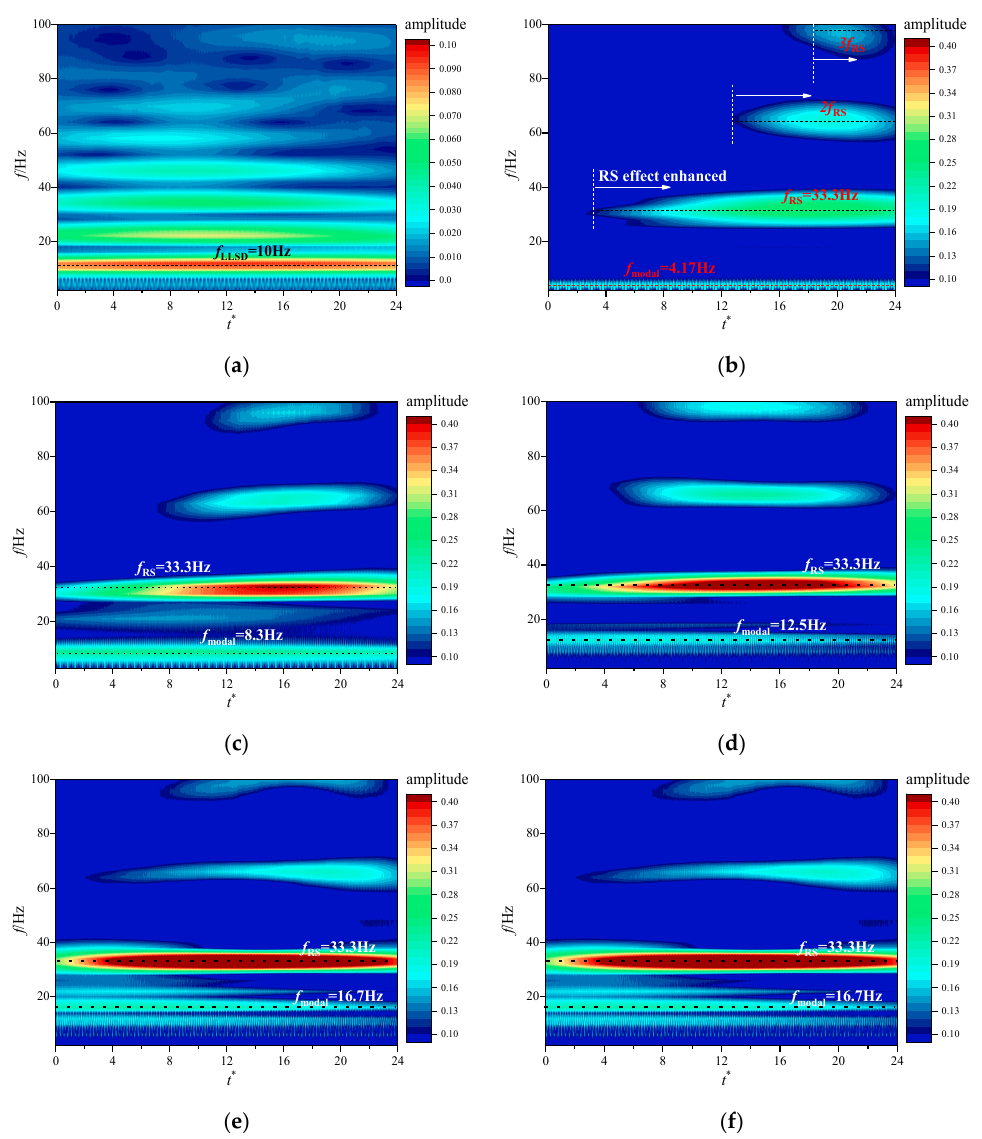
Figure 12. Spectrum chart based on CWT–OP A–F. ( a ) ϕ = 0.189 − OP-A; ( b ) ϕ = 0.186 − OP-B; ( c ) ϕ = 0.183 − OP-C; ( d ) ϕ = 0.181 − OP-D; ( e ) ϕ = 0.178 − OP-E; ( f ) ϕ = 0.176 −